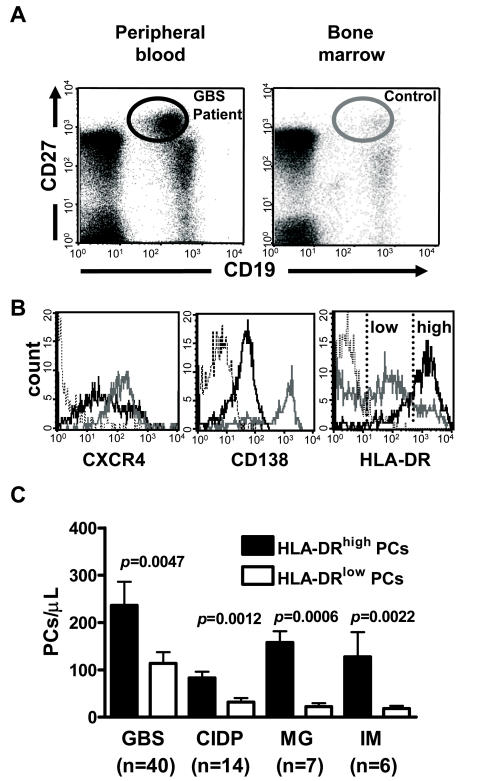
Most IVIg-mobilized CD19+CD27high cells are immature.(A) Representative analyses of circulating and bone marrow CD19+CD27high cells in a GBS patient 7 days after IVIg infusion and in a healthy bone marrow donor. (B) Control mature medullary CD19+CD27high plasma cells (as identified in panel A, right) were CXCR4highCD138highHLA-DRlow (gray line). Circulating IVIg-mobilized CD19+CD27high plasma cells were CXCR4lowCD138lowHLA-DRhigh (solid line). Isotype controls were presented (dotted line). (C) Balance between immature (HLA-DRhigh) and mature (HLA-DRlow) plasma cells (PCs) in IVIg-treated patients 7 days after treatment. GBS (disability grade 3 or more, n = 40) and CIDP (n = 14) patients received IVIg only, whereas MG (n = 7) and IM (n = 6) patients received IVIg and steroids. Data are mean ± s.e.m. Comparisons of indicated mean values were performed by use of Mann-Whitney U test.